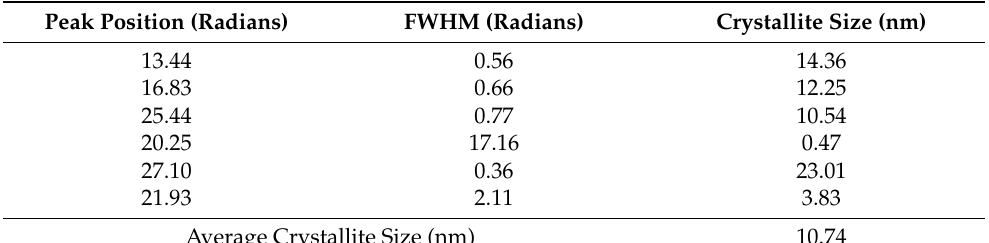
Table 3. Crystallite size for PHB powder according to peak position and FWHM values. Peak Position (Radians) FWHM (Radians) Crystallite Size (nm)